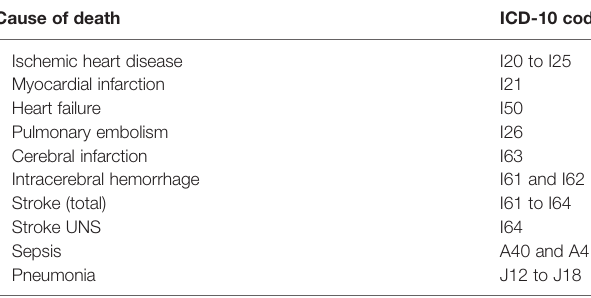
TABLE 1 | Cause of death and ICD-10